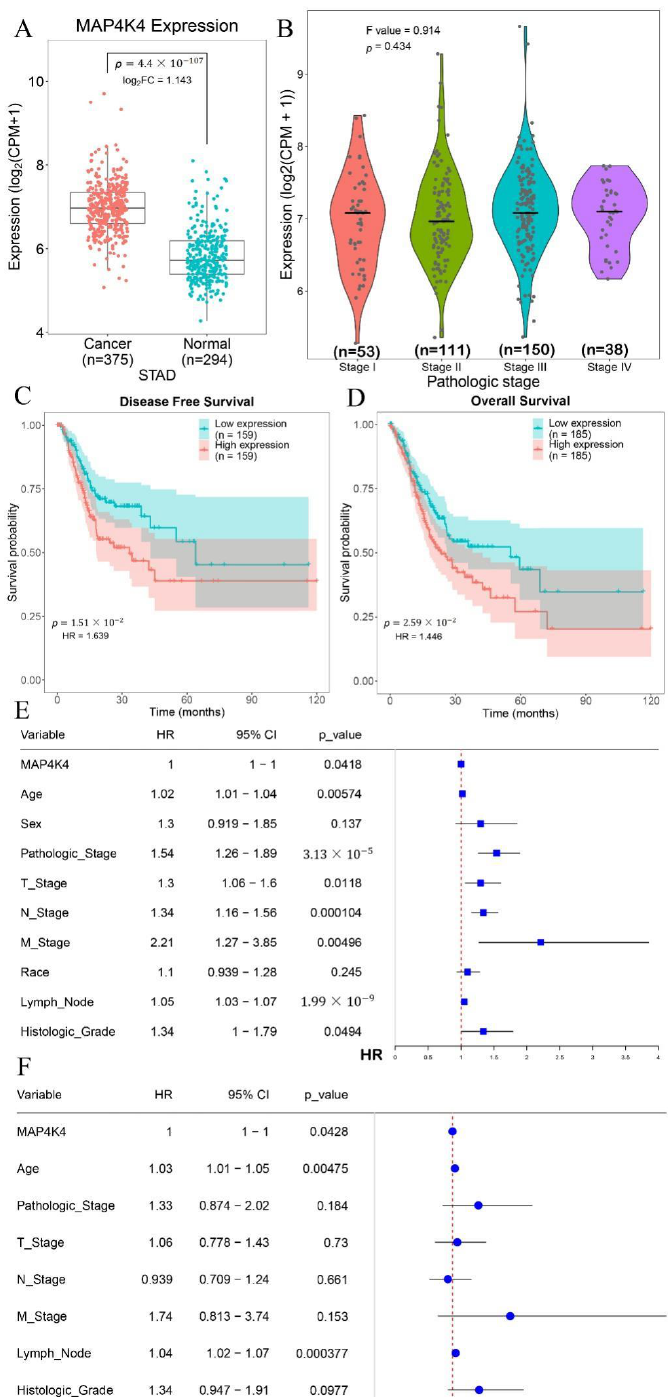
Figure 1. Differentially expressed MAP4K4 and survival differences. ( A ) Differential expression of MAP4K4 in gastric cancer and normal samples; ( B ) the expression of MAP4K4 in samples of different pathological stages; ( C ) the disease-free survival curve of high- and low-MAP4K4-expression groups; ( D ) the overall survival curve of high- and low-MAP4K4-expression groups; HR, hazard ratio of survival, and p -value was used to check the survival significance between high- and low- MAP4K4-expression groups, whereas the cl values represent the confidence levels; ( E ) the results of multivariate Cox regression analysis; ( F ) the results of univariate Cox regression analysis. The lines in plot represent 95% CI of